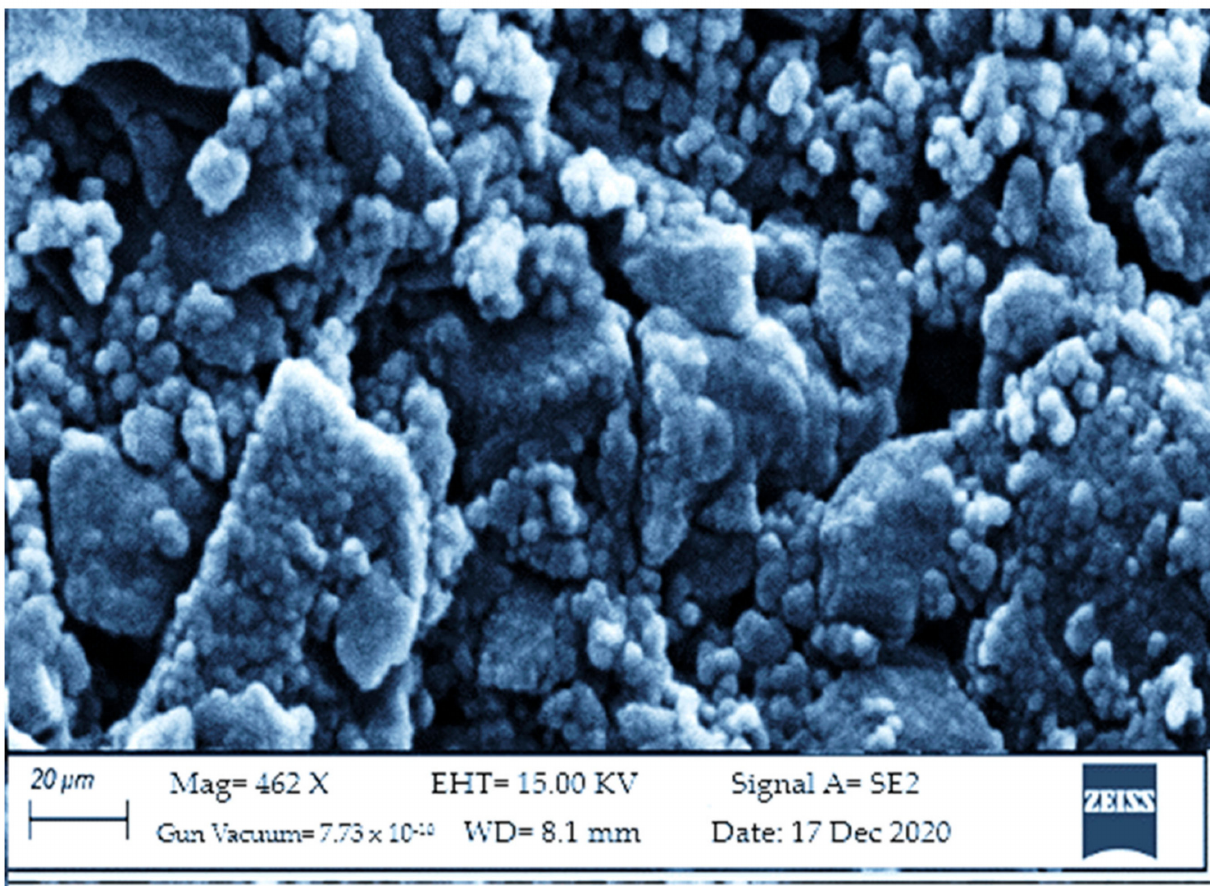
Figure 3. SEM of the composite